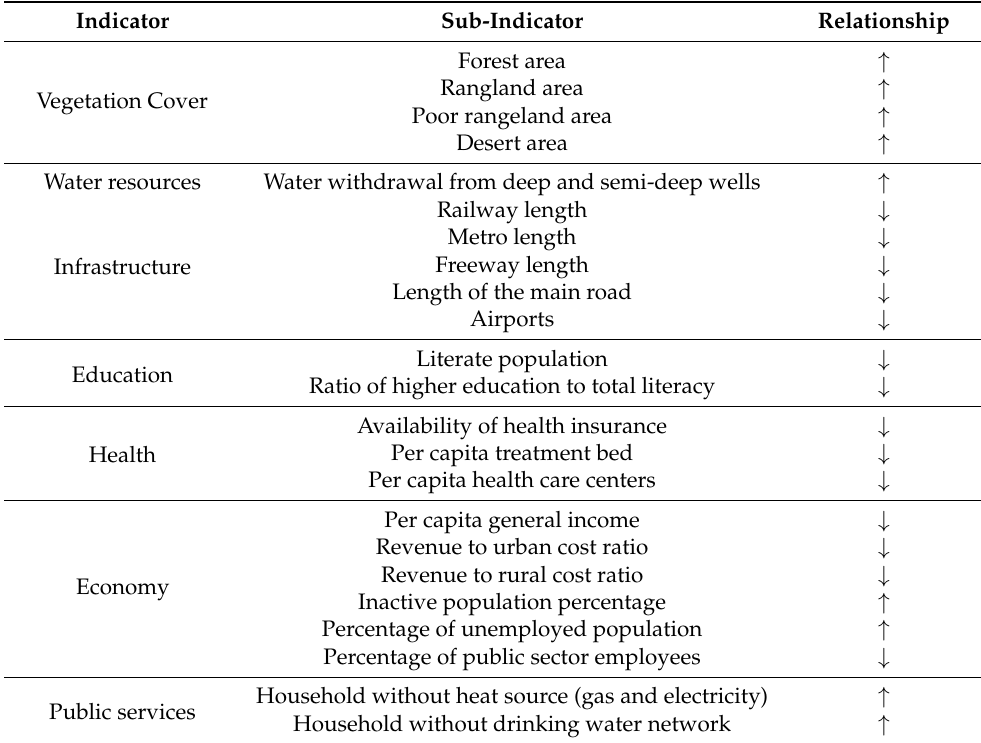
Table 4. Adaptive capacity indicators and their functional relationship with vulnerability to drought.